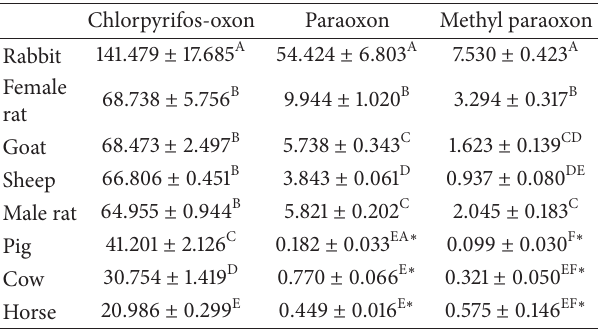
Table 1: Serum paraoxonase 1 specific activities (nmoles min − 1 mg protein − 1 ) from several mammalian species using different organo- phosphates as